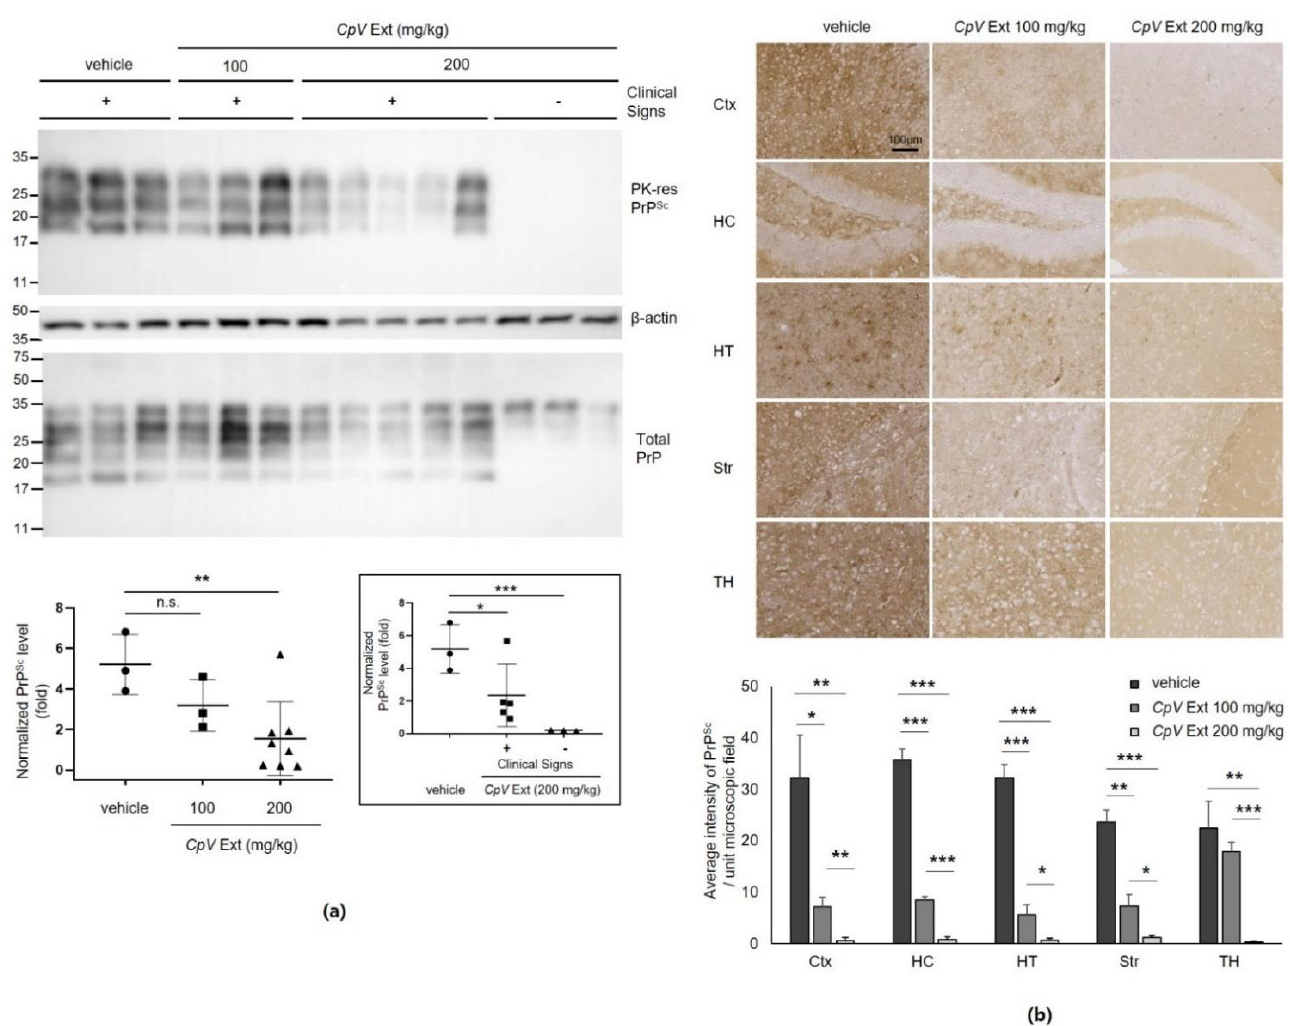
Figure 4. Decrease in PrP Sc in the brains of prion-infected mice that received CpV extract. ( a ) The level of PK-resistant (PK-res) PrP Sc in the mouse brains of each group collected at the end point of individual mouse. β -actin was used as loading control. Total PrP was detected from brain homogenate without PK digestion. The western blot of PK-res PrP Sc was quantified with densitometry. The PrP Sc level normalized with the β -actin level was plotted and compared between control and each treated group. **, p = 0.008; n.s., statistically not significant. The subgroups with (+) or without ( − ) clinical signs within 200 mg/kg group were divided and compared individually to the control group (inset). *, p = 0.046; ***, p = 3.799 × 10 − 10 . ( b ) PrP Sc immunohistochemistry and quantification of PrP Sc accumulation. A unit microscopic field is 0.245 mm 2 . *, p < 0.05; **, p < 0.01; ***, p < 0.001. Ctx, cerebral cortex; HC, hippocampus; HT, hypothalamus; Str, striatum; TH,